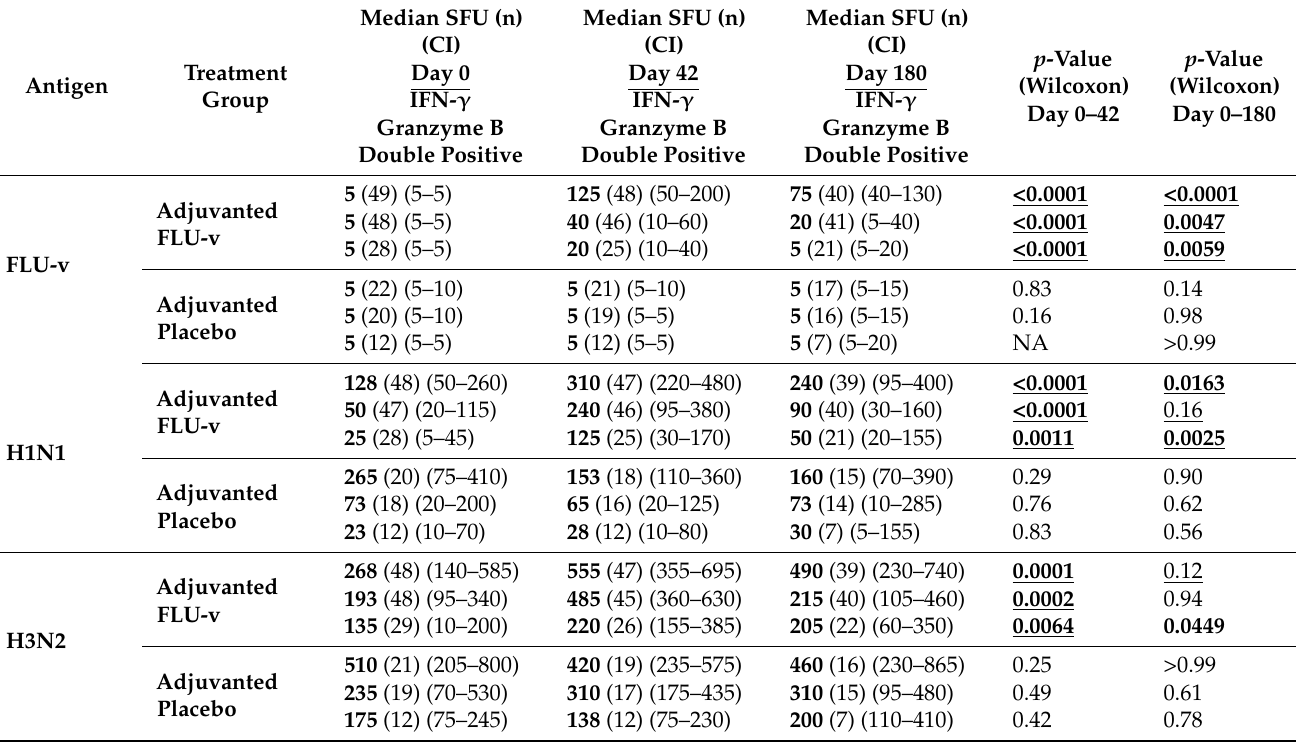
Table 2. Median number of IFN- γ -secreting, granzyme-B-secreting, and double positive cells (SFU/million cells) in response to FLU-v and whole inactivated influenza strains (A/California/7/2009 (H1N1), A/Shanghai/24/1990 (H3N2), A/Vietnam/1194/2004 (NIBRG-14) (H5N1), A/Anhui/1/2013 (NIBRG-268) (H7N9), and B/Brisbane/9/2014 (Yamagata lineage)) in the group vaccinated with adjuvanted FLU-v and the placebo group on days 0, 42, and 180. n = number of samples to be included in statistical analysis. CI = 95% confidence interval. Wilcoxon signed rank sum test was used to analyze differences between day 0 and 42 and between day 0 and 180 in each group. Significant differences are indicated with p -values in